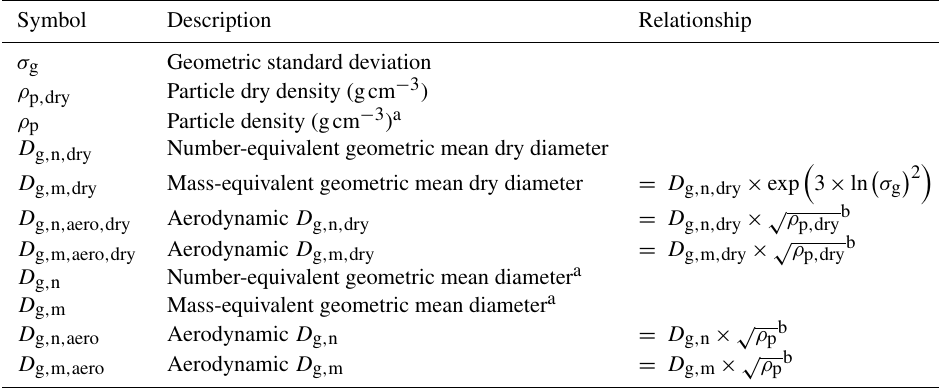
Table 3. Symbols used for aerosol size parameters and their relationships. Symbol Description Relationship σ g Geometric standard deviation ρ p , dry Particle dry density (gcm − 3 ) Particle density (gcm − 3 ) a D g , n , dry Number-equivalent geometric mean dry diameter D g , m , dry Mass-equivalent geometric mean dry diameter Aerodynamic D g , n ,